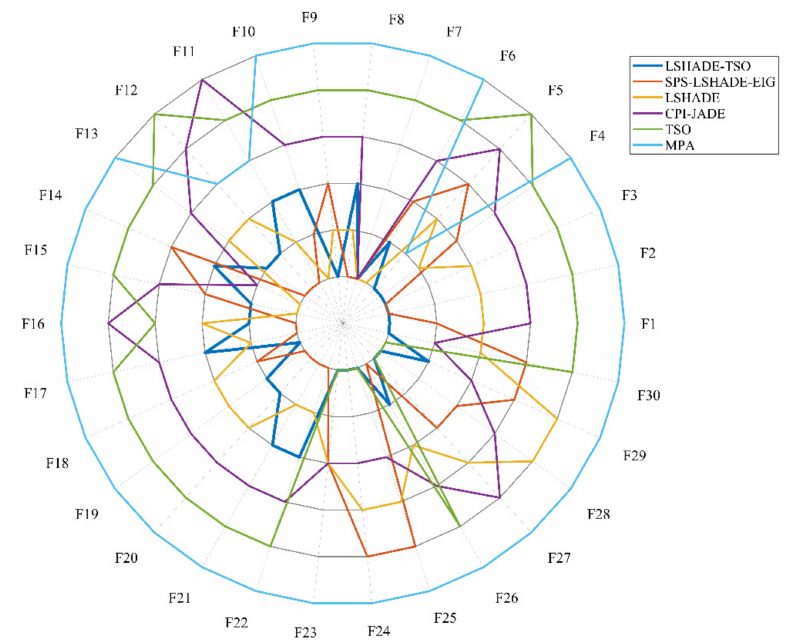
Figure 6. Radar chart of algorithm ranking.